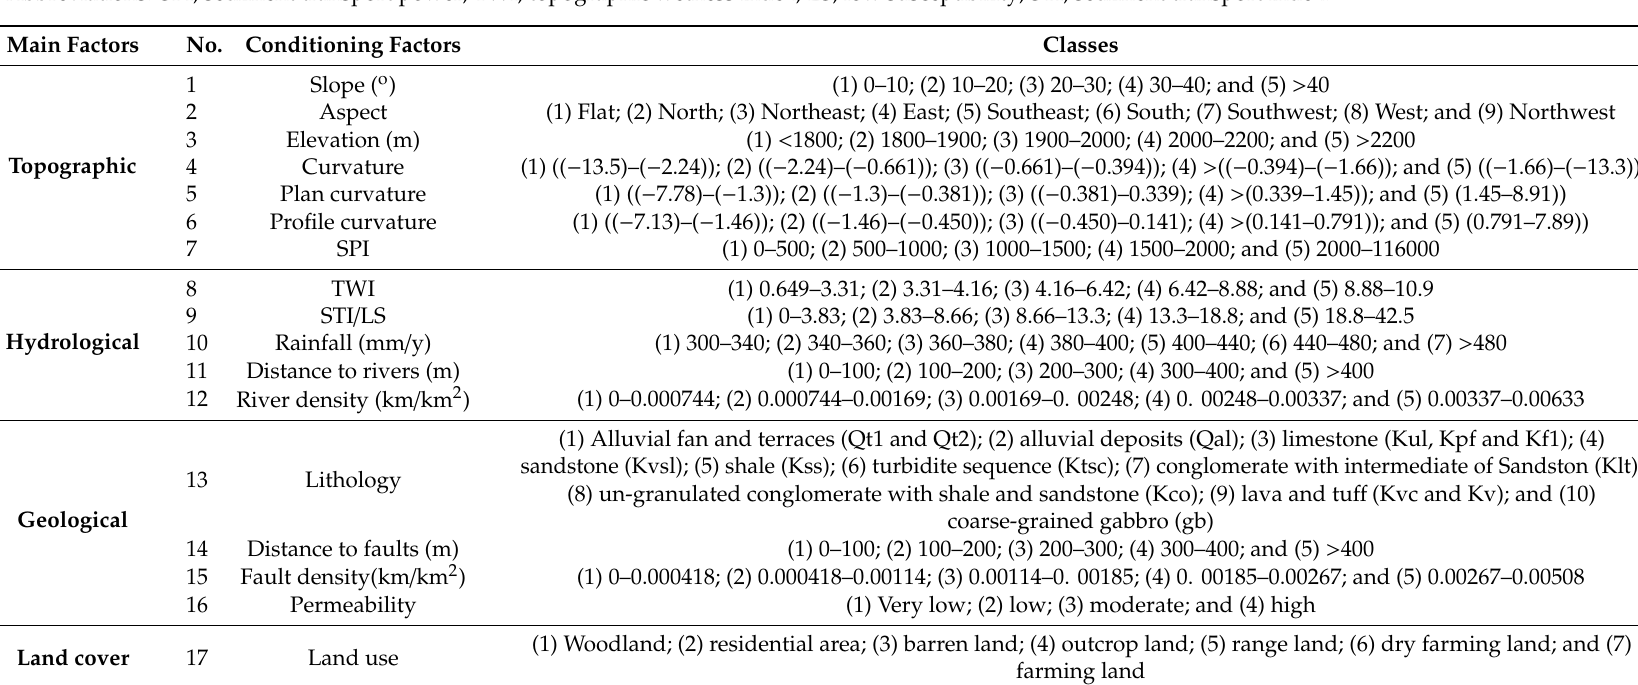
Table 2. Groundwater spring conditioning factors and their classifications for modeling groundwater spring potential mapping (GSPM) at Chilgazi watershed. Abbreviations: SPI, sediment transport power; TWI, topographic wetness index; LS, low susceptibility; STI, sediment transport